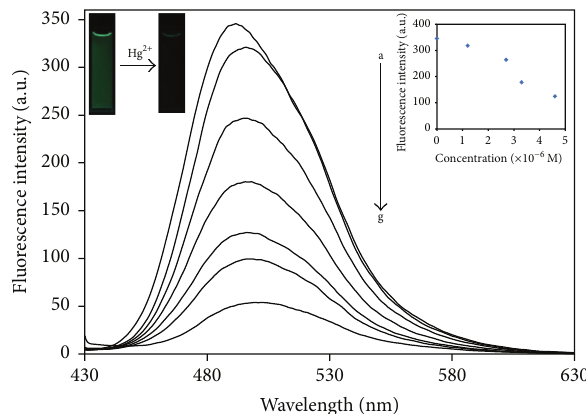
Figure 3: Fluorescence spectra ( 𝜆 420 nm) of 2 (0.82 𝜇 M) in ex CH 2 Cl 2 as a function of [Hg 2+ ]. a: 0 M, b: 1.2 𝜇 M, c: 2.7 𝜇 M, d: 3.3 𝜇 M, e: 4.6 𝜇 M, f: 24.3 𝜇 M, and g: 79.6 𝜇 M. (The inset shows intensity of sensor 2 versus concentration of Hg 2+